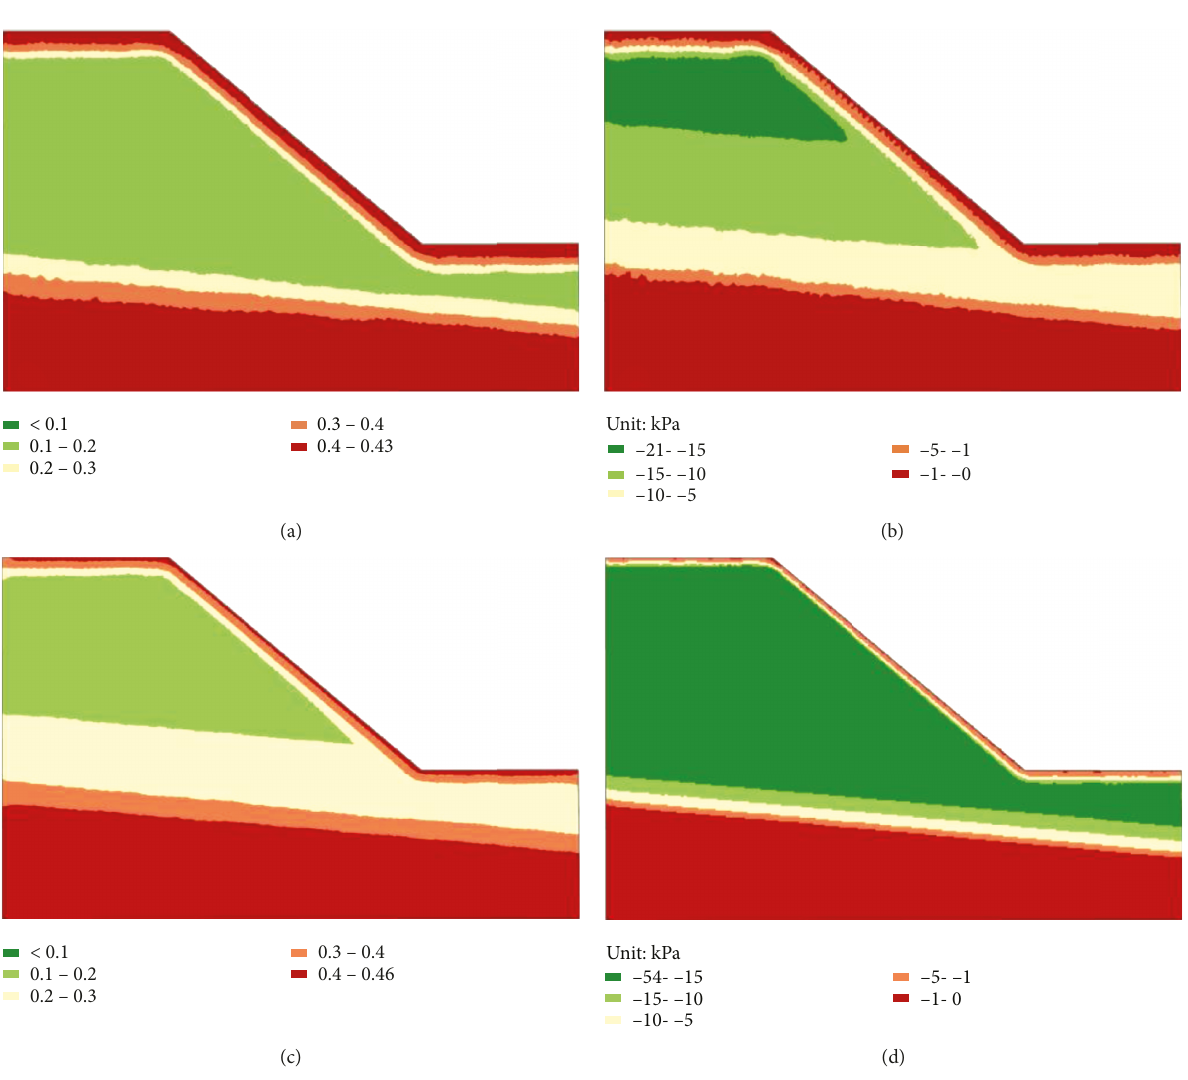
Figure 10: Results of water content and suction stress in di ff erent soil slopes at 48 hours under rainfall conditions: (a) water content distribution in the loam slope; (b) suction stress distribution in the loam slope; (c) water content distribution in the silt slope; (d) suction stress distribution in the silt